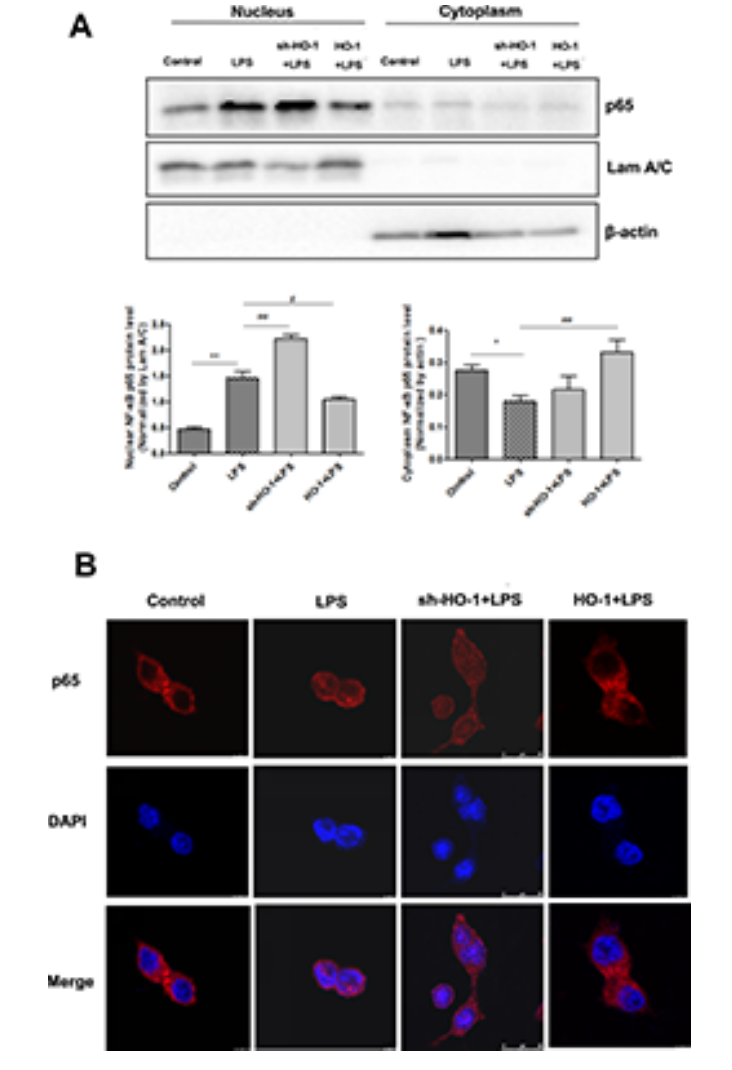
Figure 5. HO-1 overexpression inhibits NF- κ B nuclear translocation. Cytoplasmic and nu- clear proteins were extracted, and NF- κ B p65 was determined by Western blot analysis (A, B). The expression levels of β -actin and Lamin A/C were used as loading controls. * P < 0.05, ** P < 0.01 compared with control group; # P < 0.05, ## P < 0.01 compared with LPS treatment group. (C) Immunofluorescence staining results for NF- κ B p65. Red is p65; blue is DAPI